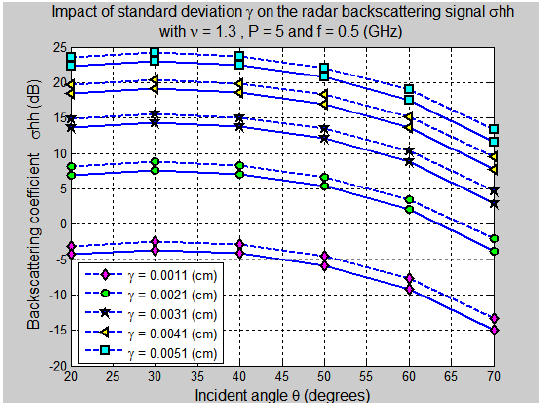
Figure 5: Backscattering coefficient dependence on fractal Figure 7: Backscattering coefficient dependence on 𝛄 , parameter ν at HH polarization for bare soil (dashed line) and parameter related to the Root Mean Square at HH polarization for vegetated soil (full line) for bare soil (dashed line) and for vegetated soil (full line) the parameter related to the standard deviation, increases.